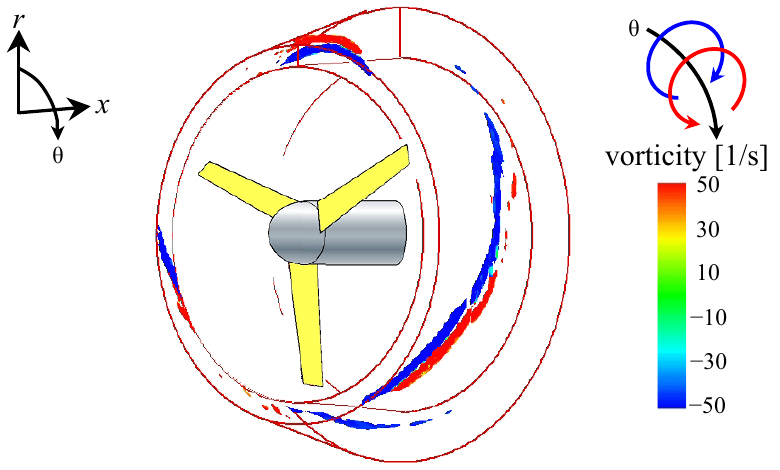
Figure 9. Wind tunnel experimental results for the long-type Wind-Lens turbine: θ -component of the vorticity inside a long-type Wind-Lens turbine